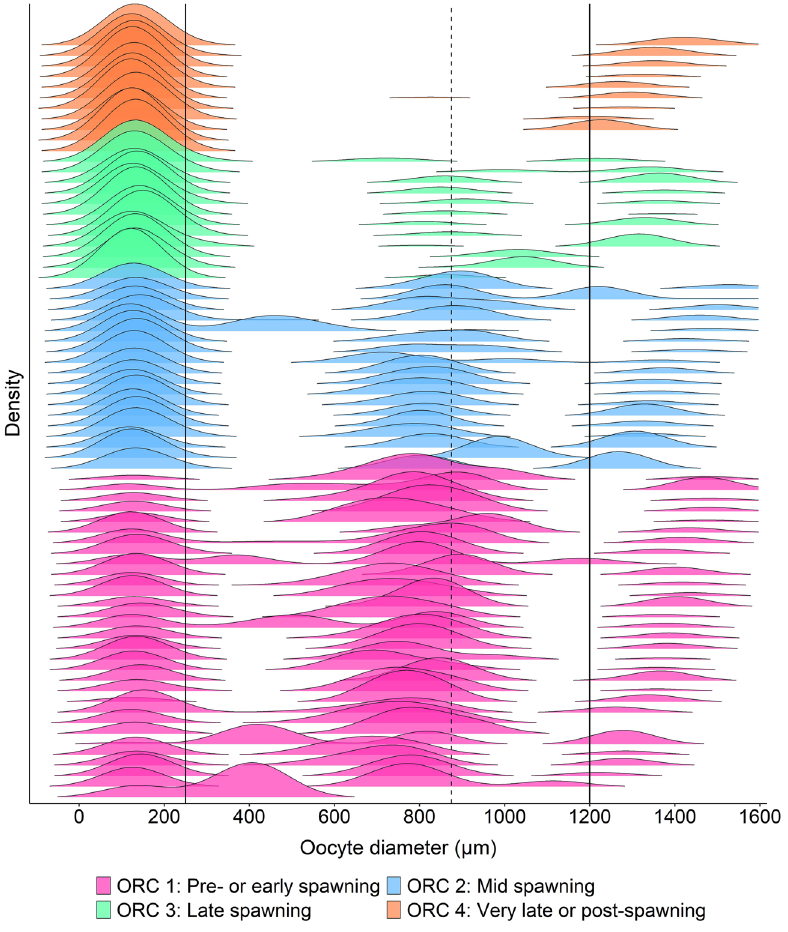
Figure 3. Smoothed OSFD profile plot for all fish sampled in this study. Each OSFD is coloured by ORC, and the order of the plots is based on ascending maximum oocyte diameter within each ORC. Other details as for Fig.